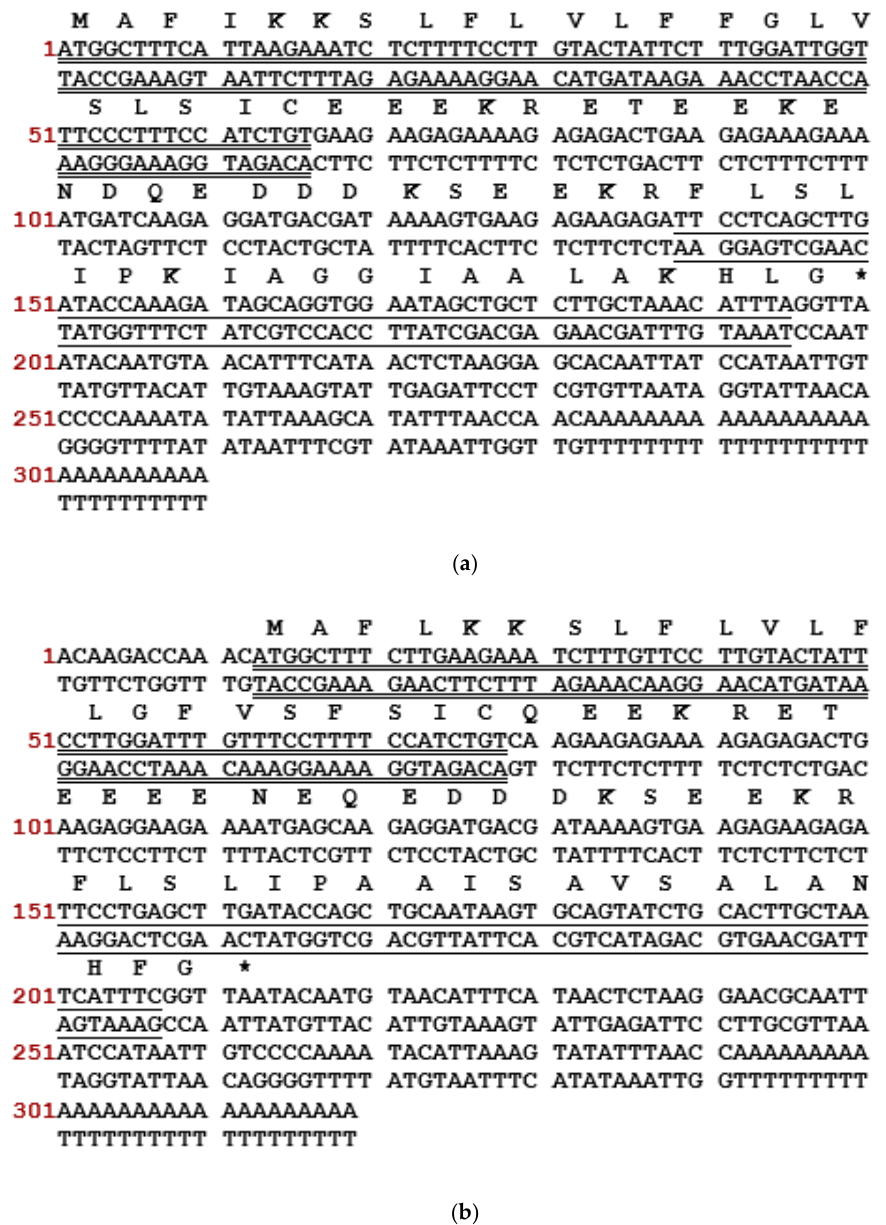
Figure 1. Nucleotide and translated open-reading frame amino acid sequence of cloned cDNA encoding the precursor of ( a ) phylloseptin-PTa and ( b ) phylloseptin-PHa. The putative signal peptide is double-underlined, the mature peptide is single-underlined and the termination codon is marked by an asterisk.